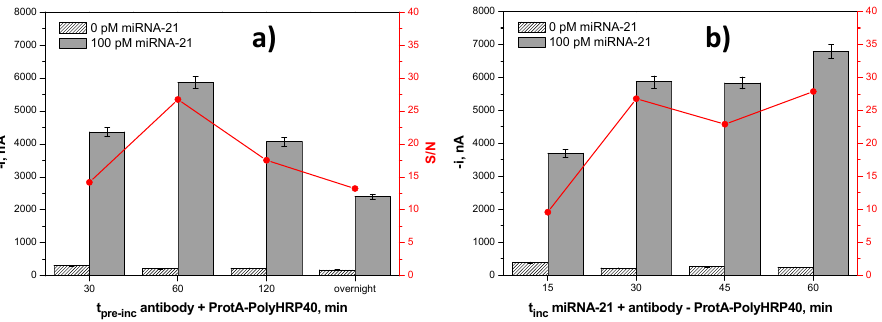
Figure 3. Dependence of the amperometric responses obtained with the developed biosensor in the absence (N) and in the presence of 100 pM (S) miRNA-21 and the resulting S/N current ratios, with the pre-incubation time of anti-DNA–RNA hybrid antibody and ProtA–PolyHRP40 mixture solution ( a ), and with the incubation time of b-DNACp-MBs with the mixture solution containing the target miRNA and the anti-DNA–RNA hybrid antibody preincubated for 1 h with the ProtA–PolyHRP40 ( b ). Error bars estimated at triple of the standard deviation of three replicates.